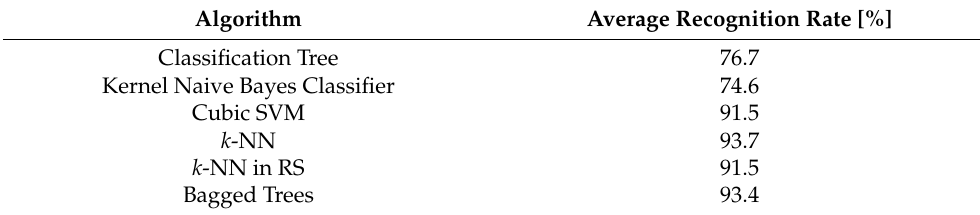
Table 1. The average effectiveness of each of the 6 classifiers tested.